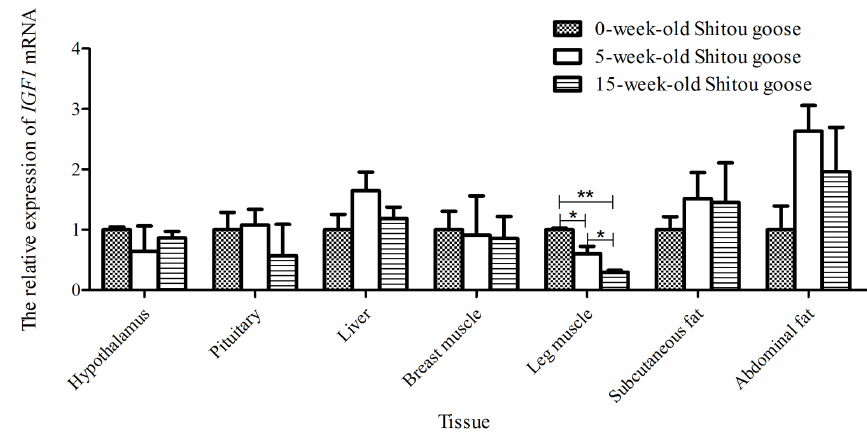
Figure 6. The mRNA expression of the IGF1 gene in three periods for a Shitou goose.